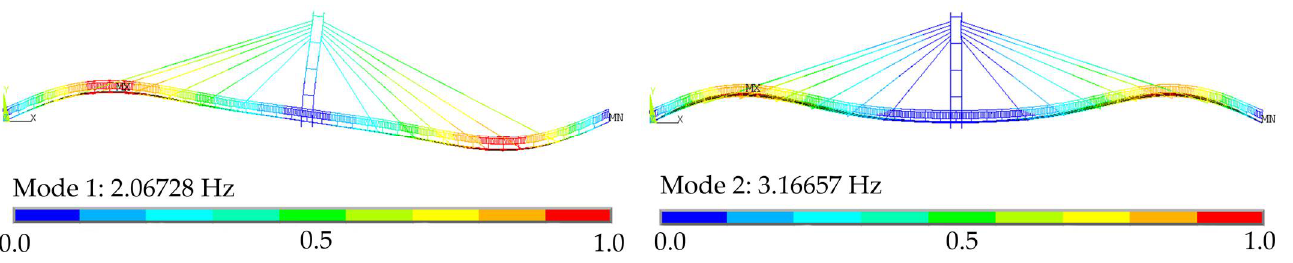
Figure 3. Vertical mode shapes of the structure.